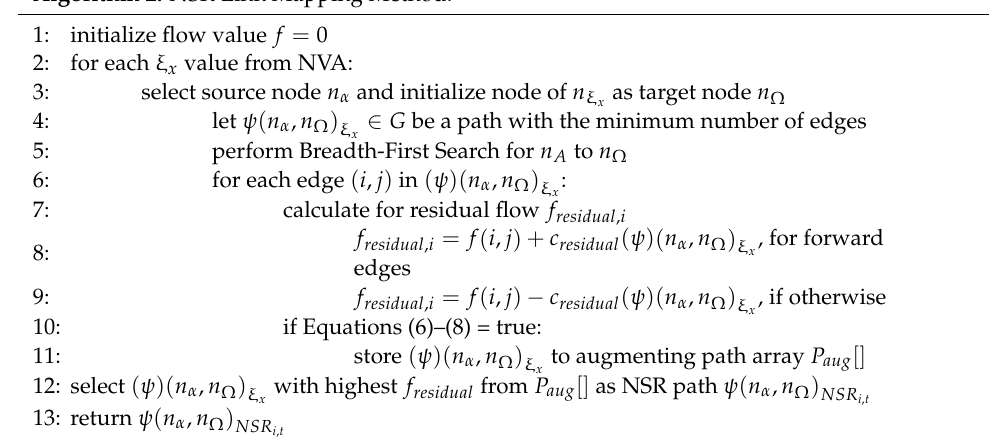
Algorithm 2. NSR Link Mapping Method.